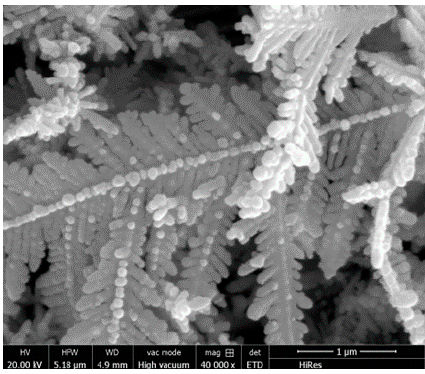
Figure 3. Scanning electron microscopy (SEM) image of the surface morphology of nanobranched ZnO grown on a PEDOT:PSS-coated flexible substrate of PET.